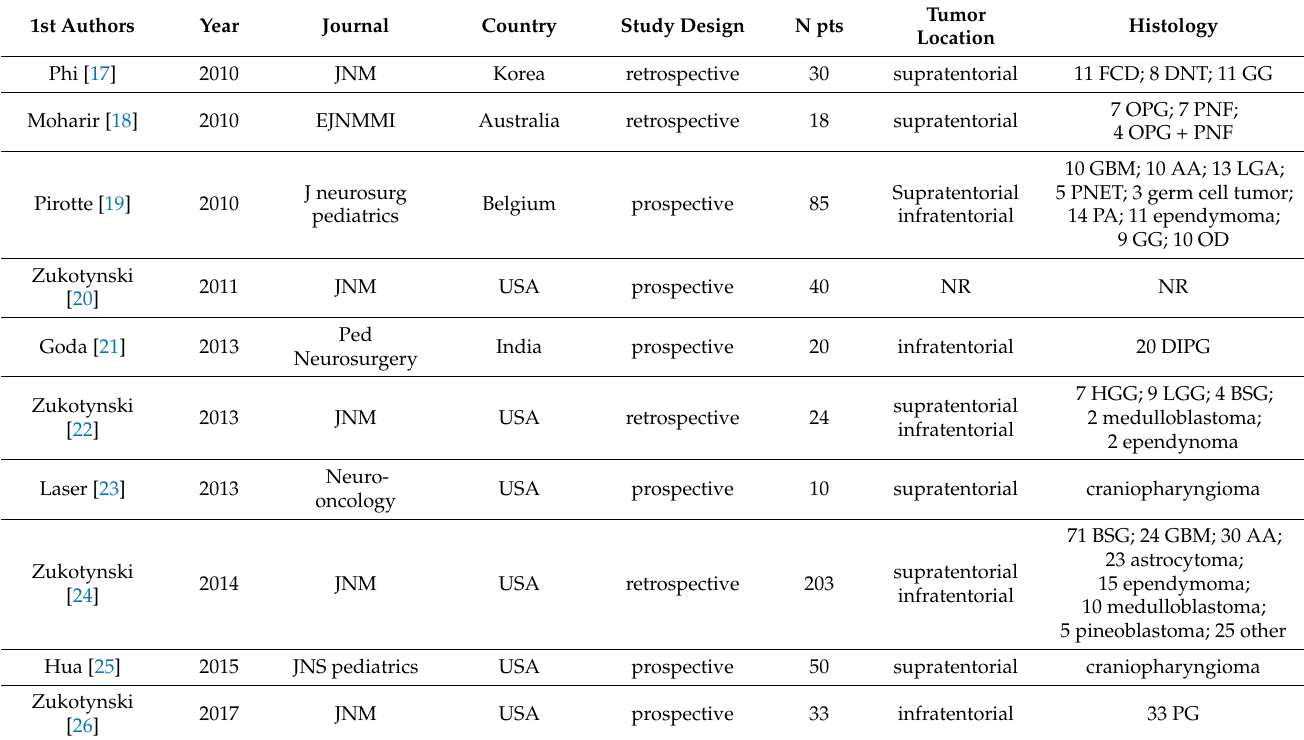
Table 1. Biographical features of the main studies using 18F-FDG PET imaging in pediatric brain